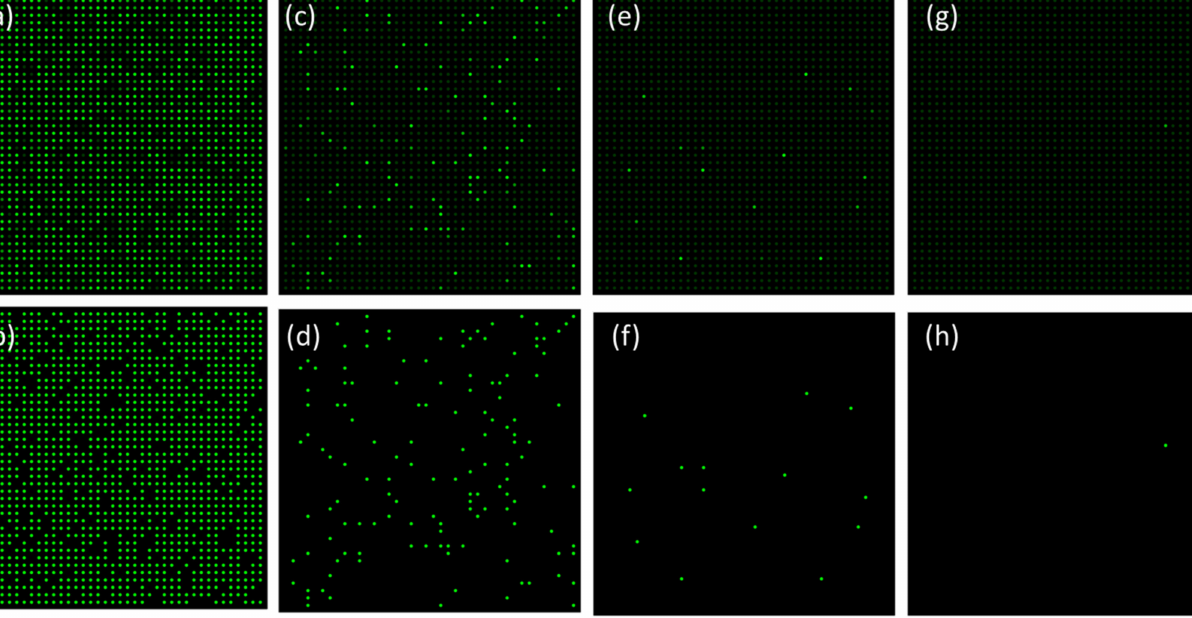
Figure 2. Fluorescence images before and after image process to read out the total number of positive chambers. ( a , c , e , g ) are original images from the CCD camera, with DNA template concentration of 1 × fold, 0.1 × fold, 0.01 × fold, 0.001 × fold dilutions, respectively; ( b , d , f , h ) are post-processed images